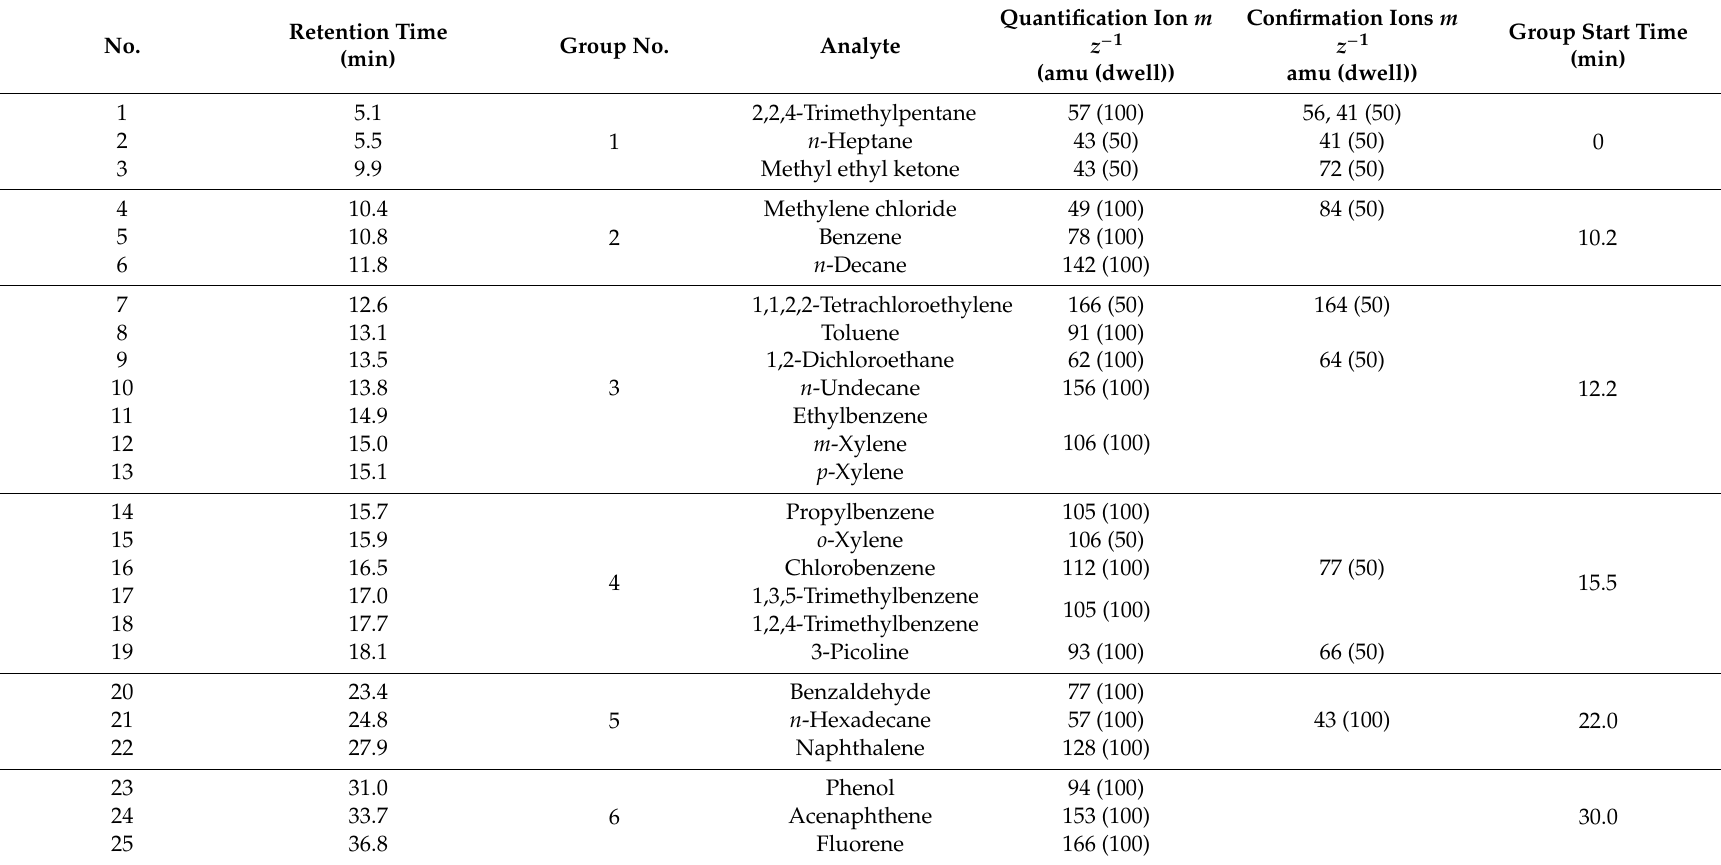
Table 2. MS detection program of analytes in SIM